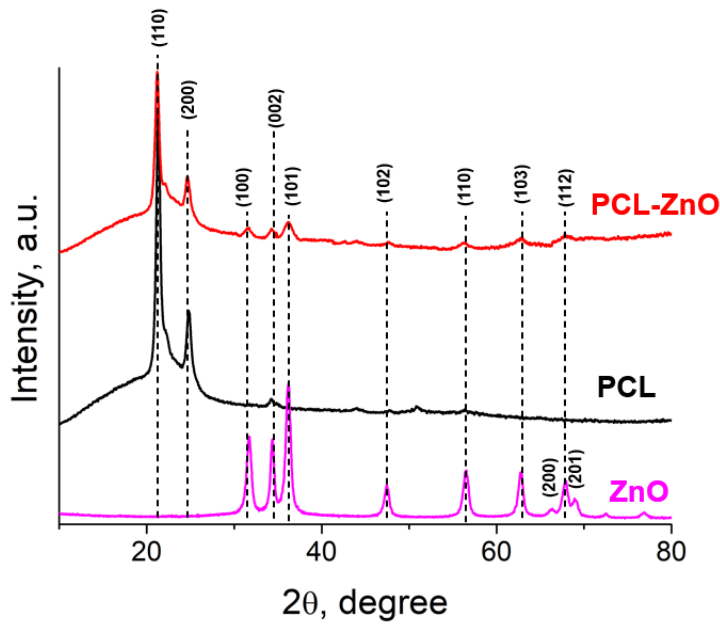
Figure 5. XRD pattern of ZnO NPs, PCL and PCL-ZnO membrane.